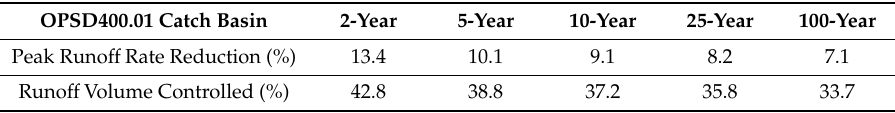
Figure 9. Hydrographs of an OPSD400.01 catch basin ( a ) inlet and outlet hydrographs; and ( b ) bypassed hydrographs. Table 5. Runoff control performances of OPSD400.01 catch basin.